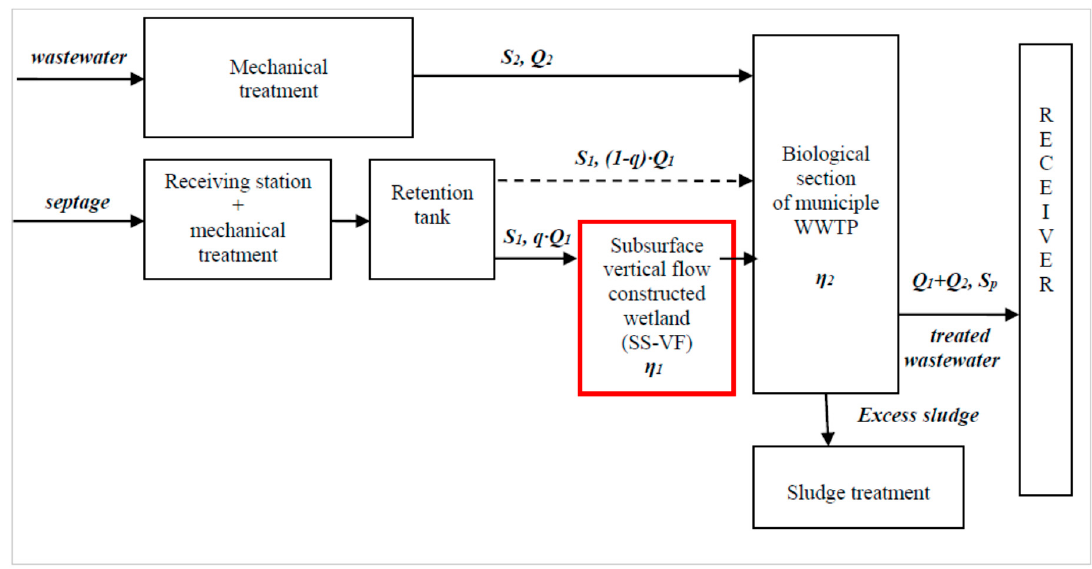
Figure 3. Figure 3. Block diagram of the alternative variant of wastewater and septage treatment—optimization issue.